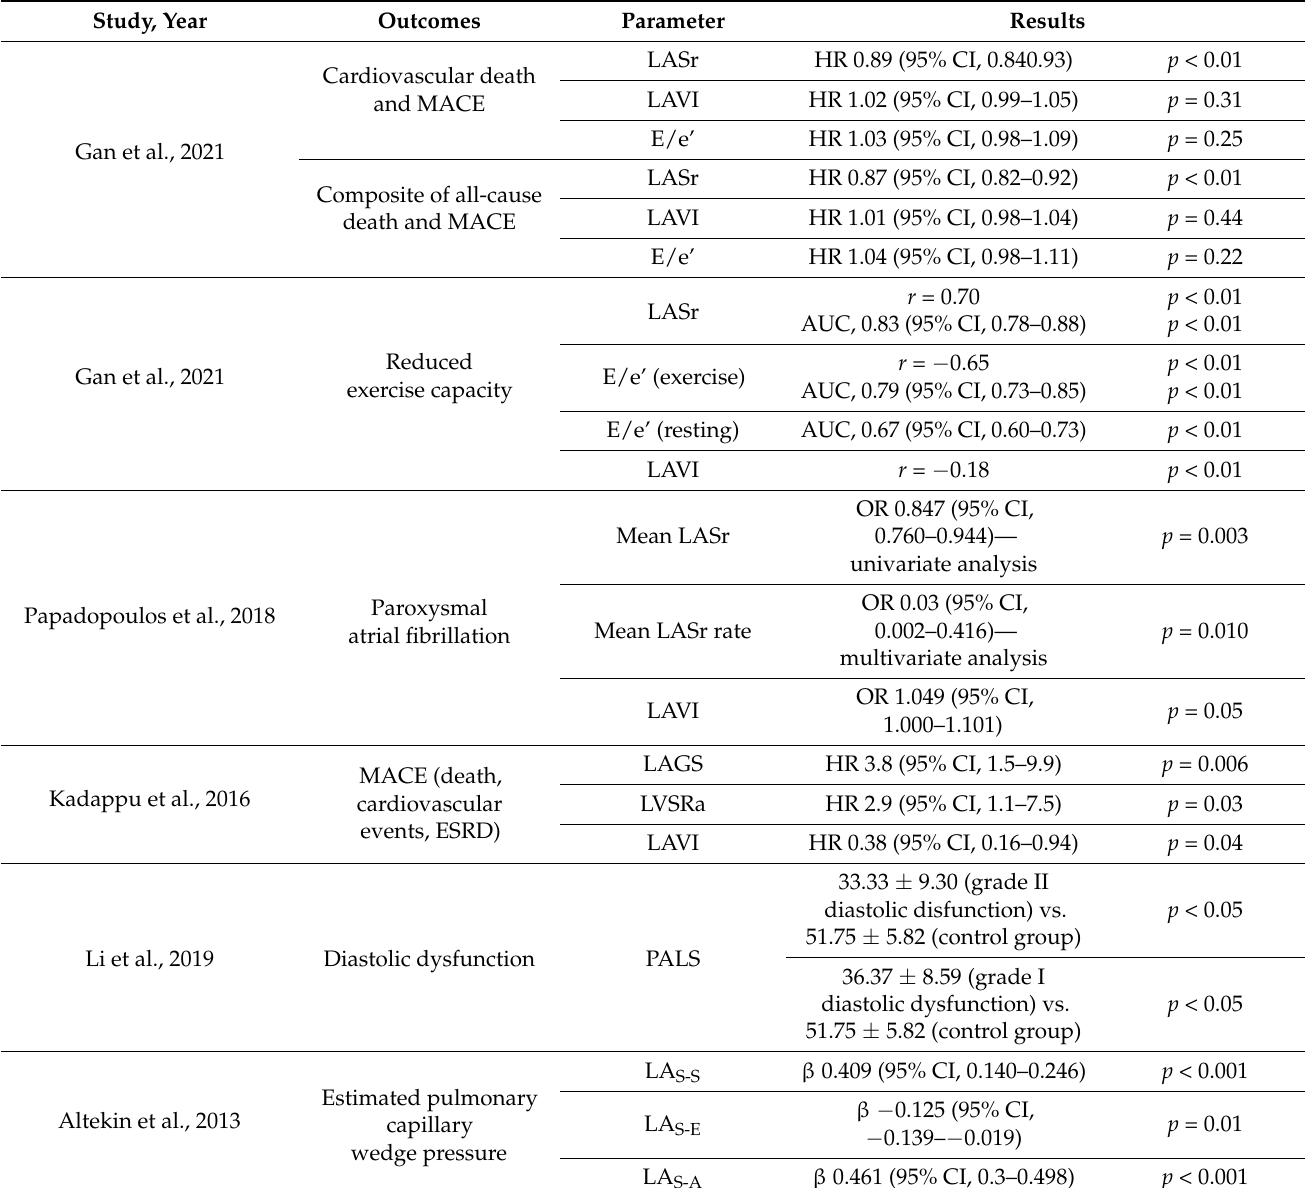
Table 2. Results reported in studies included in present systematic